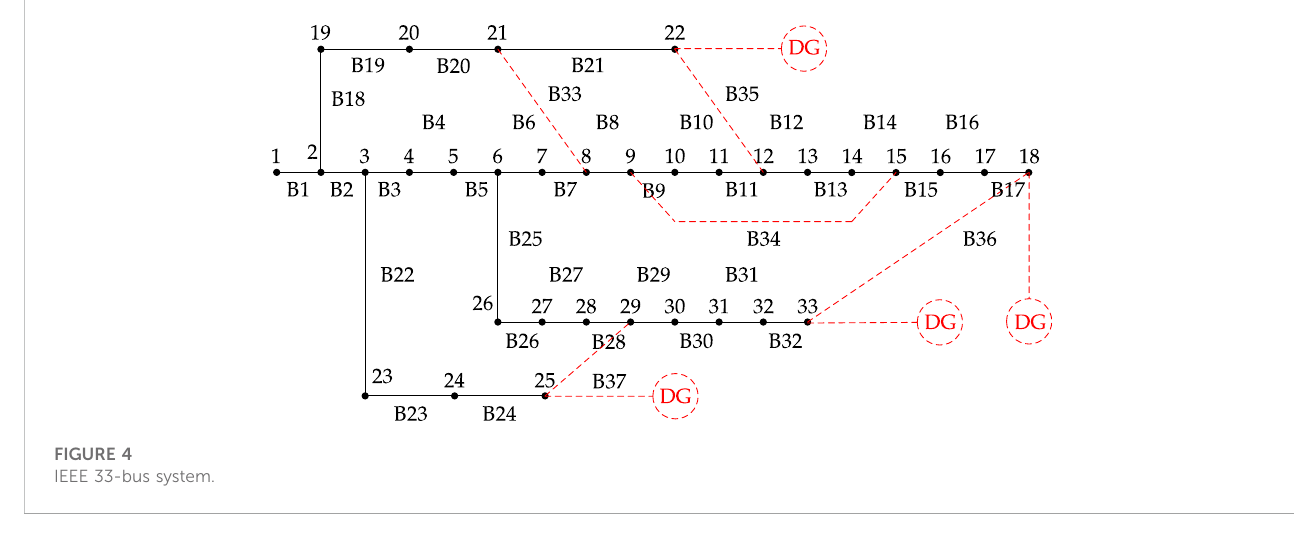
FIGURE 4 IEEE 33-bus system.